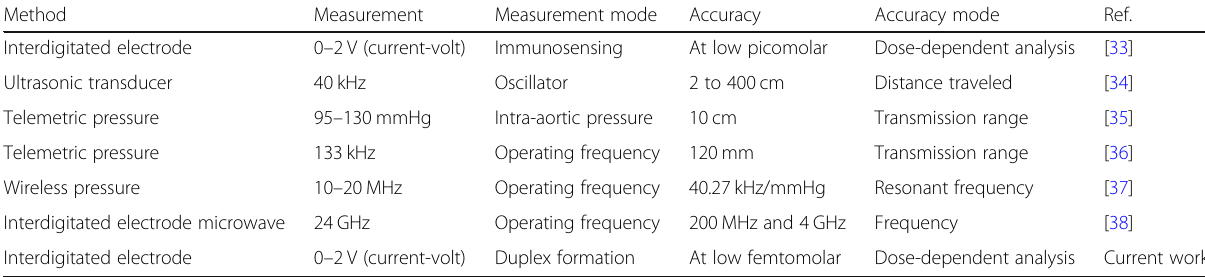
Table 1 Comparison with the current detection methods